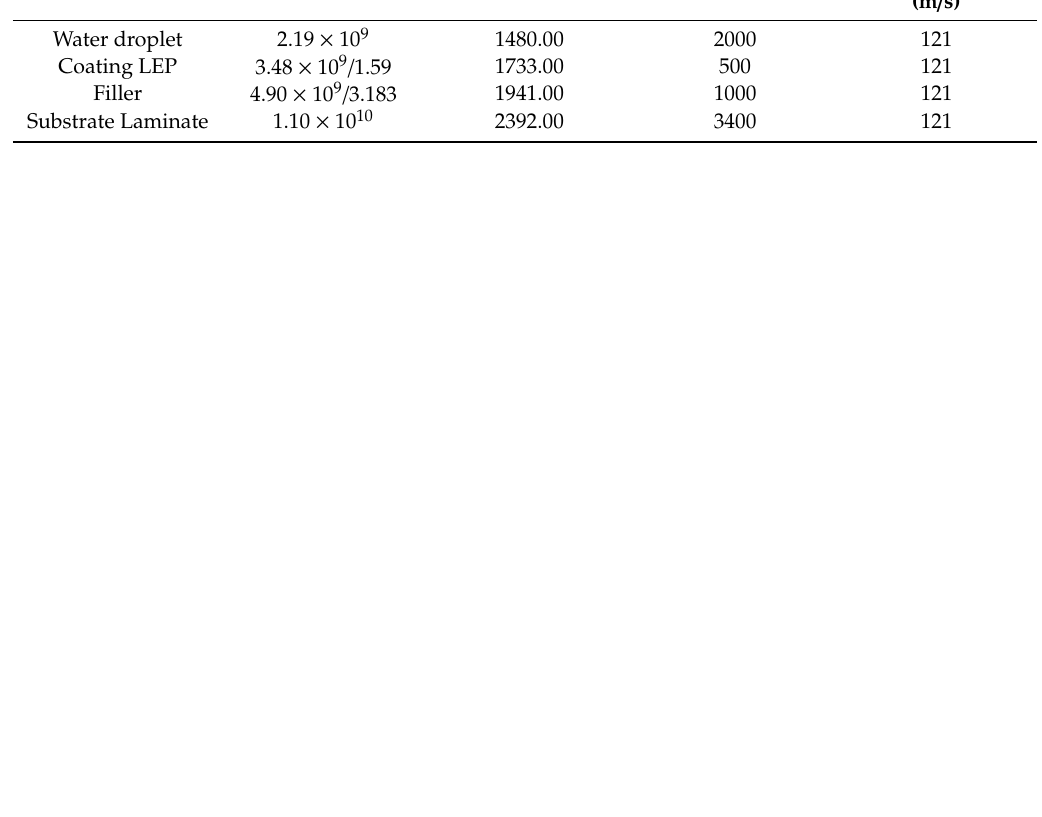
Figure 14. Rain erosion test facility and three specimens used at PolyTech Test & Validation A/S according to DNV-GL-RP-0171 [22] for the analysis and experimental validation.